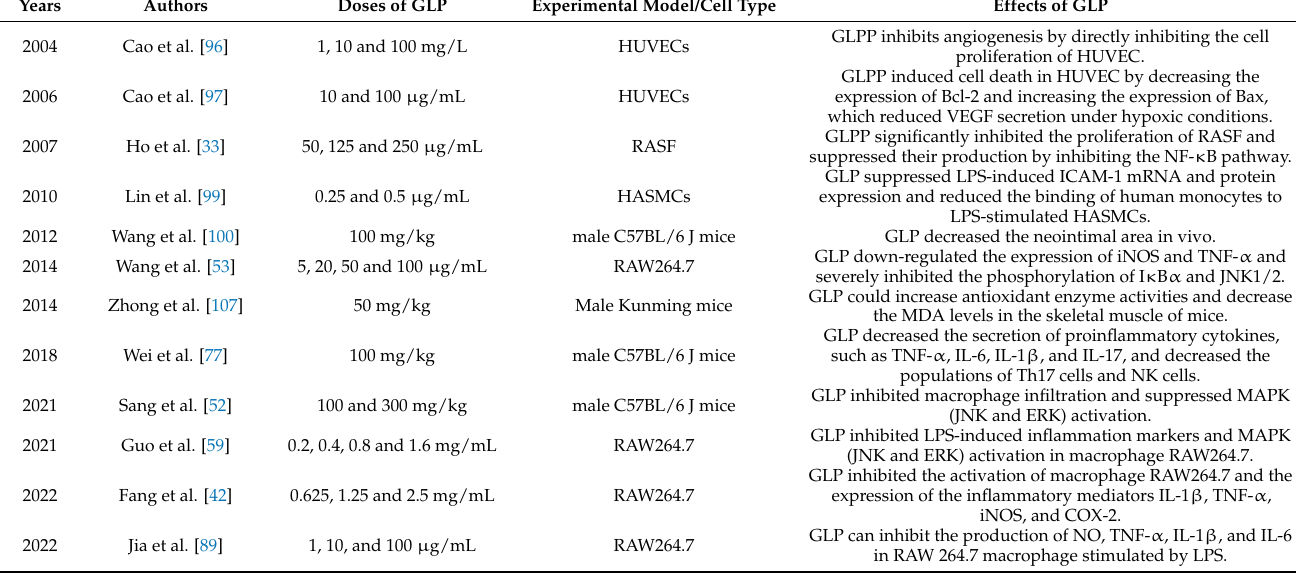
Table 1. The role of GLP in different experimental models/cell